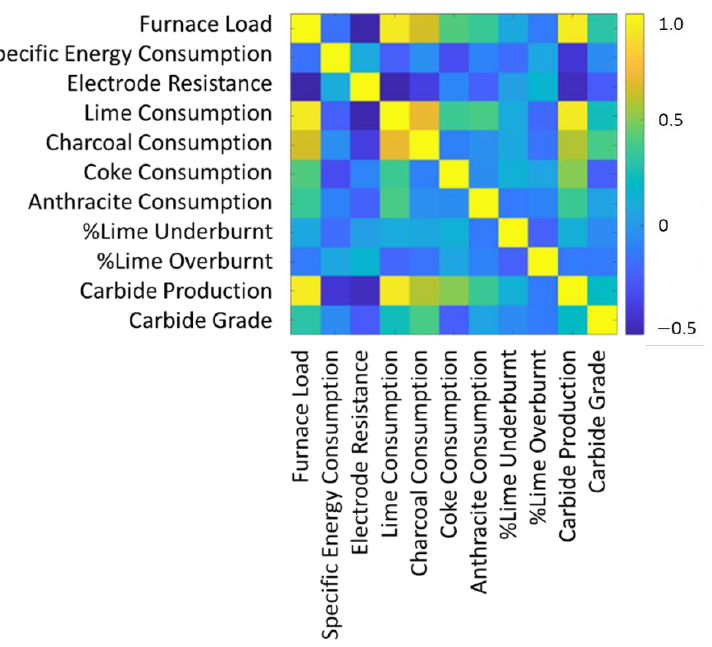
Figure 4. Correlogram of the calcium carbide furnace variables.